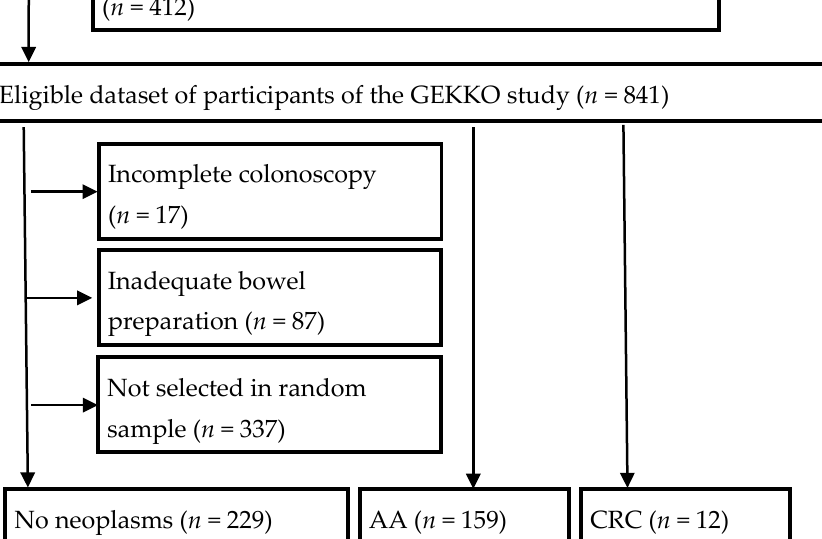
Figure 1. Flow diagram with inclusion and exclusion criteria.